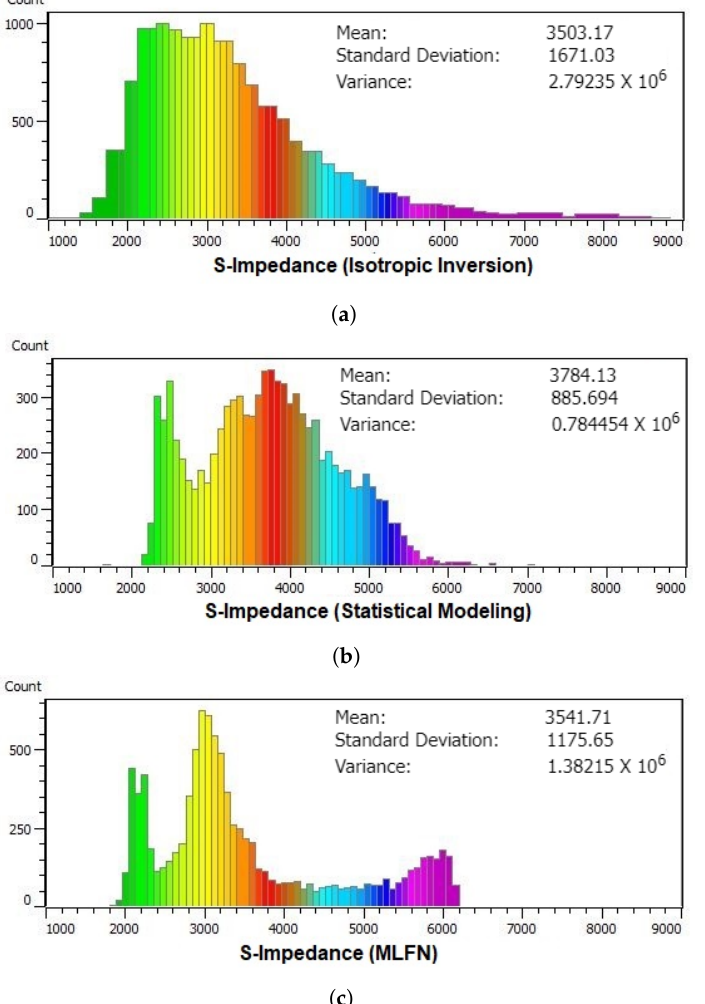
Figure 19. The histogram plots of the zero-offset S-impedance obtained from ( a ) isotropic inversion, ( b ) statistical modeling, and ( c )